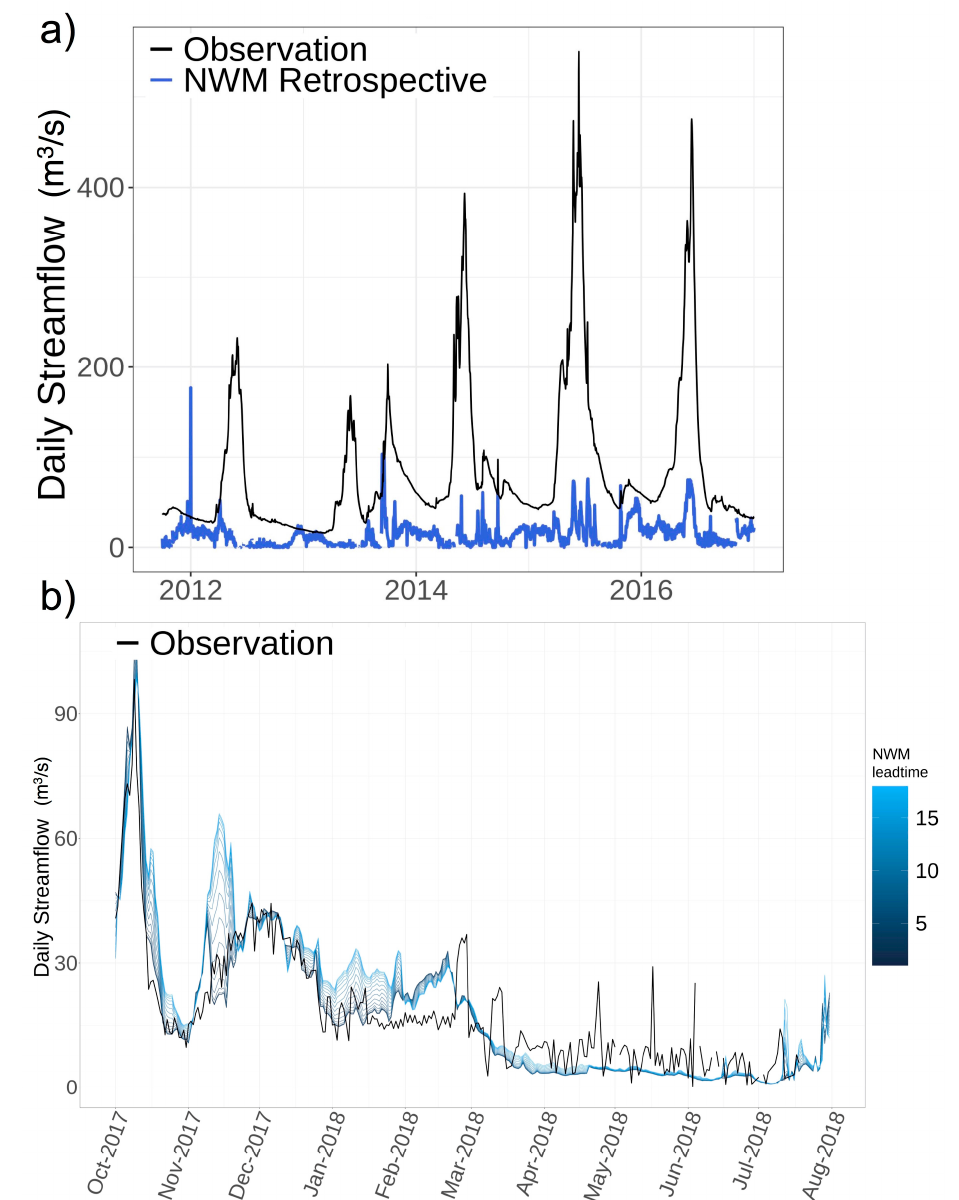
Figure 9. NWM simulated reservoir inflows into Elephant Butte Reservoir: ( a ) illustrates the NWM retrospective simulation (v1.2 in blue) against observations (black) for a 5-year period; ( b ) shows the Elephant Butte Reservoir simulated reservoir inflows for a one-year forecast period, where the blue lines are the modeled flows for all lead times and black is the BoR observations.